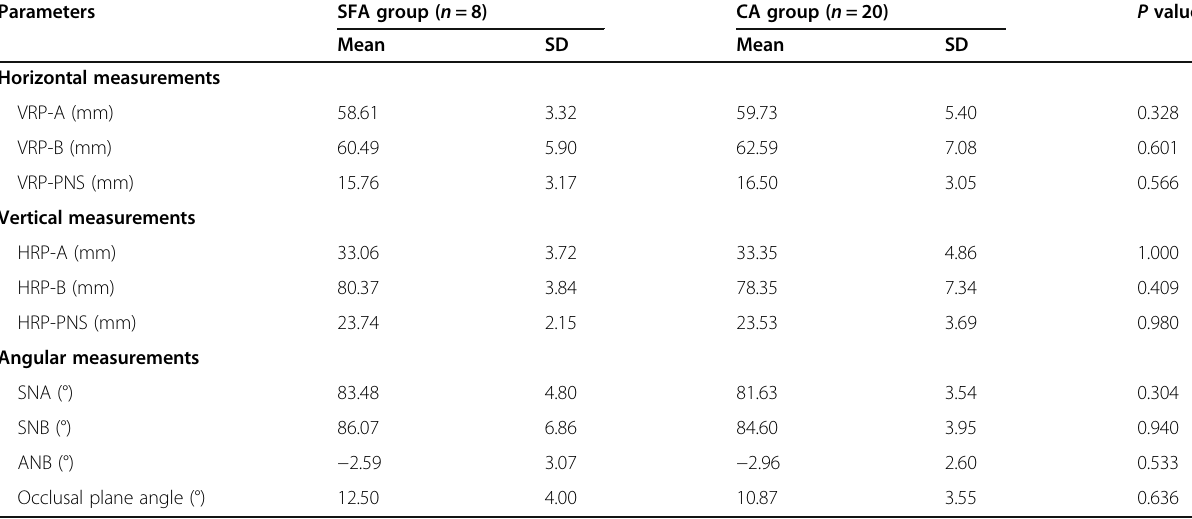
Table 2 Comparison of Experimental group and Control group on the pre-surgical stage (T1) Parameters